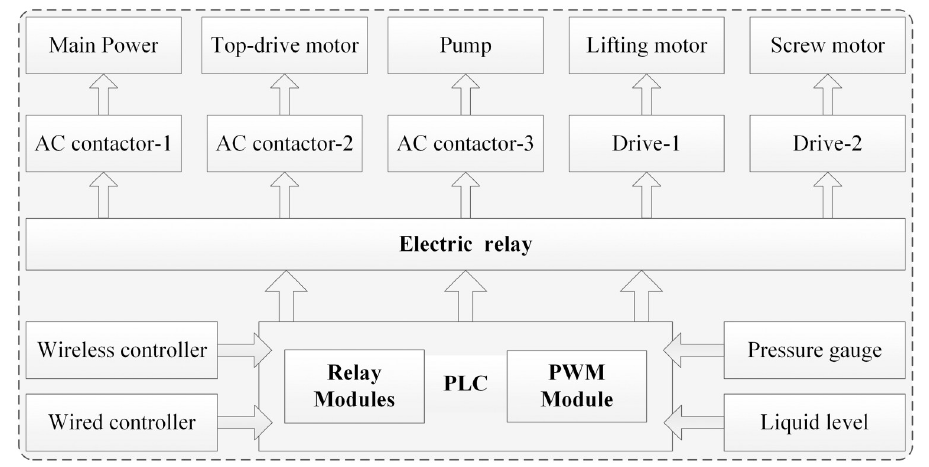
Fig 10. The modules diagram of control system.